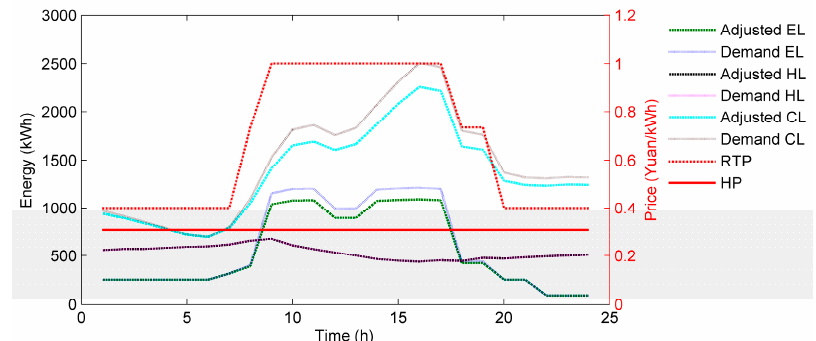
Figure 10. Strategies of NE in Scenario 3.